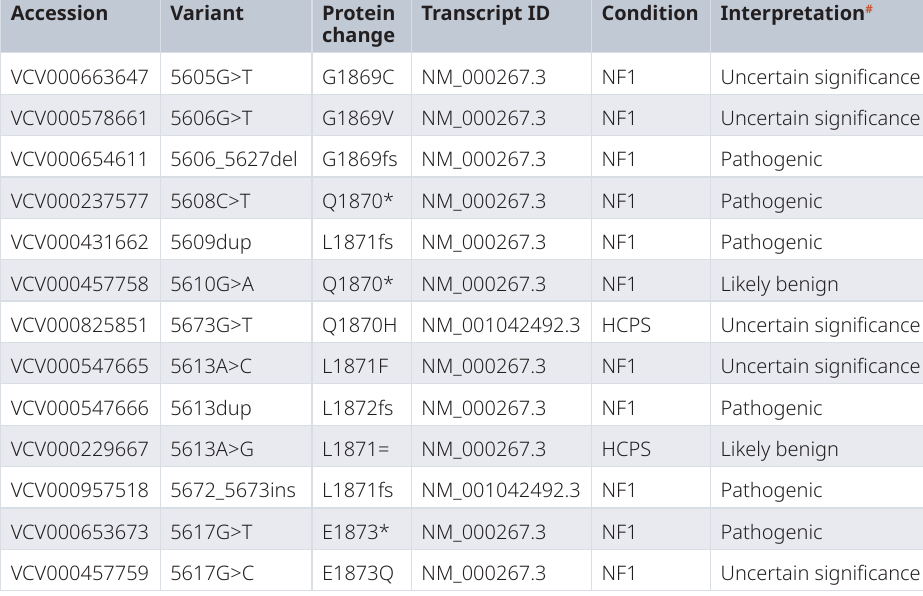
Table 1. ClinVar record of variants within 10 nucleotides of the identified c.5612T>A